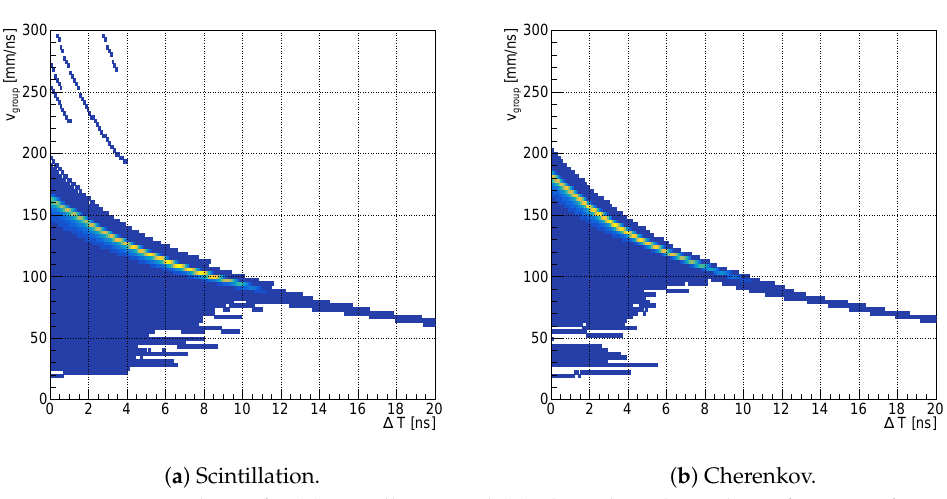
Figure 4. Group velocity for ( a ) scintillation and ( b ) Cherenkov channel as a function of time ∆ T passed since arrival t 0 , profiled using the signal pulse amplitude per sampling time per SiPM.